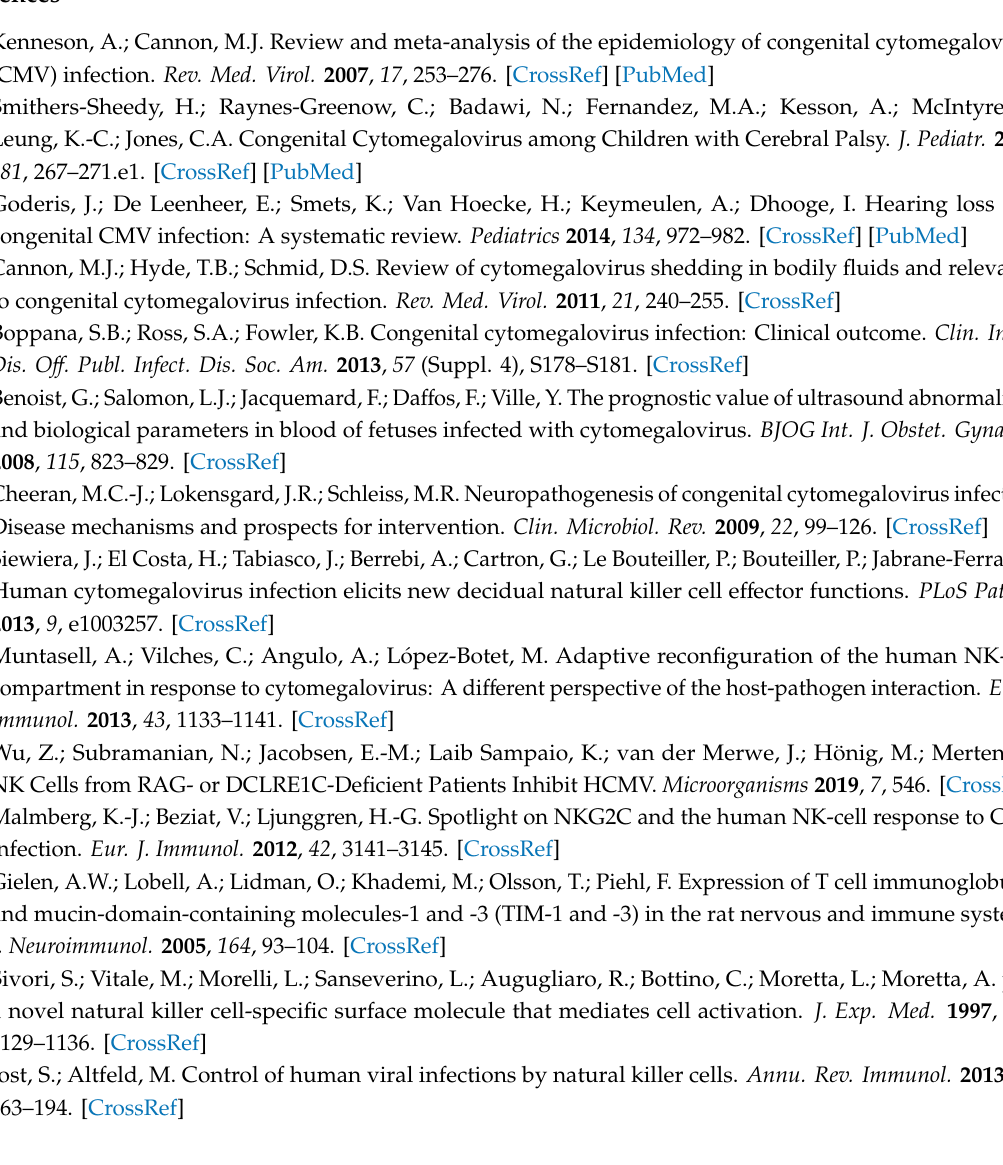
Table S1: Macroscopic and microscopic cerebral abnormalities at post-mortem examination of infected brains samples; Table S2: Antibodies used for immunohistochemistry; Figure S1:Coronal sections for immunohistochemistry included the cortical zone, the white matter, the ventricular zone and the germinative zone. Author Contributions: M.L.-V. (virologist), B.B. (pathologist) and Y.S. (midwife) designed the study. B.B. (pathologist), F.E.-R. (pathologist) and Y.V. (obstetrician) contributed to data collection and the classification